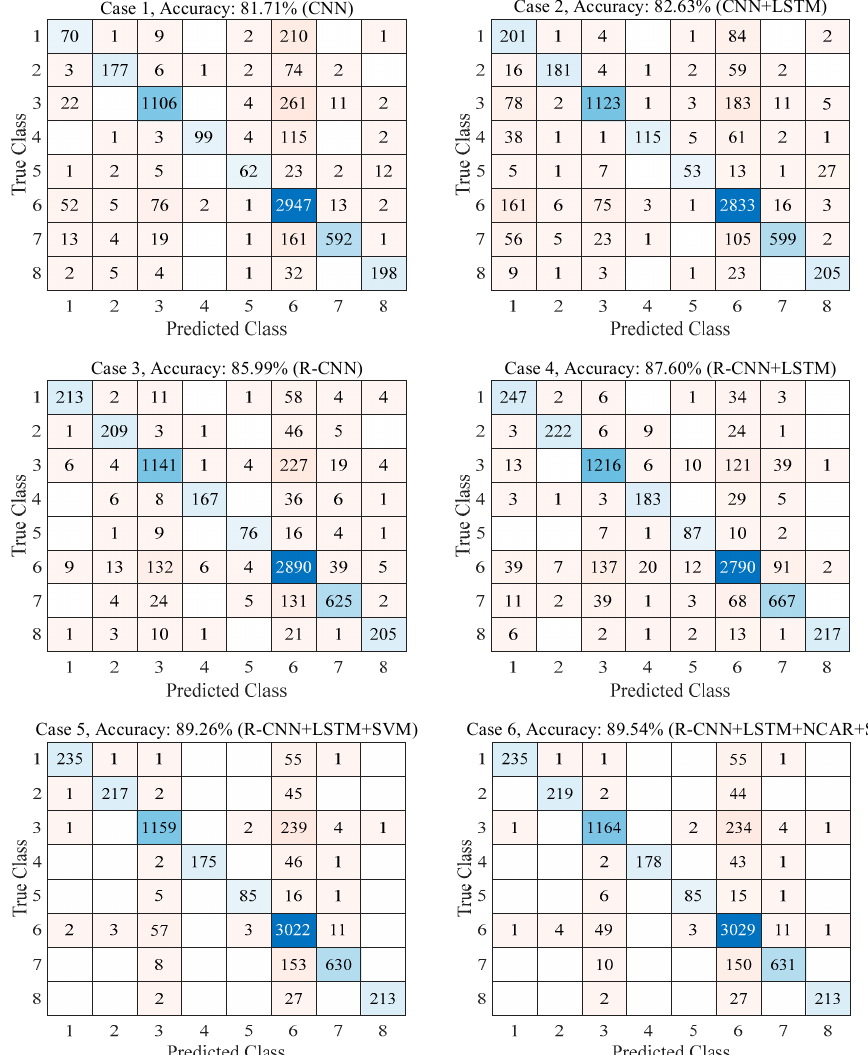
Figure 9. Confusion matrices for six different approaches ( 1 : AMD, 2 : Cataract, 3 : Diabetes, 4 : Glaucoma, 5 : Hypertension, 6 : Normal, 7 : Other Disease, 8 : PM). Table 3. The other performance results of the proposed approach.